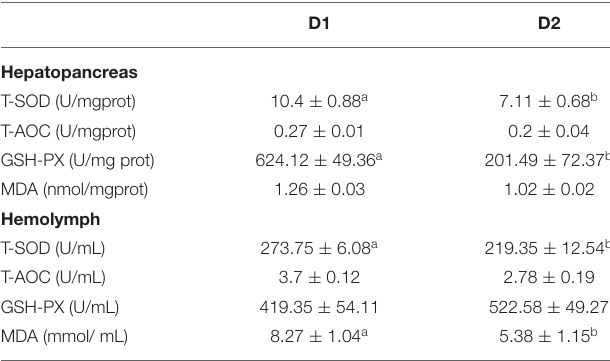
TABLE 5 | Hepatopancreas and hemolymph antioxidant parameters of L. vannamei fed diets supplemented with/without Klebsormidium sp. for 56